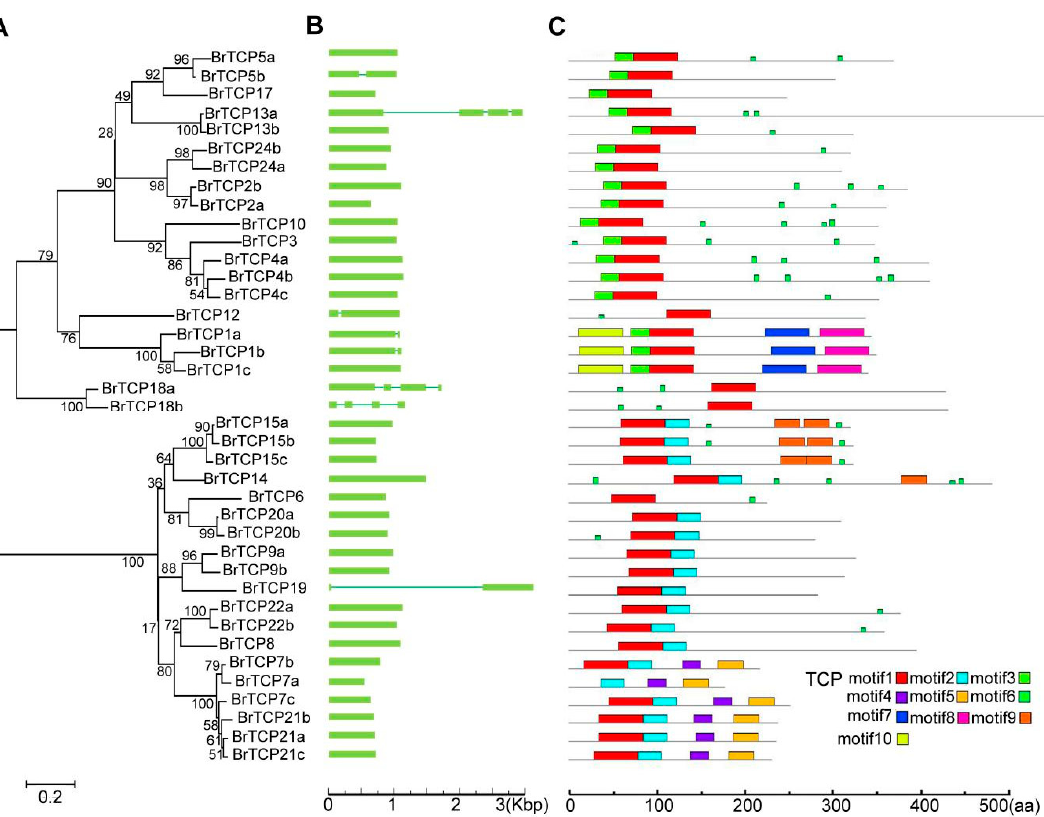
Figure 3. The Phylogenetic tree, gene structure and multiple motifs of TCP family in Chinese cabbage. ( A ) Phylogenetic tree was constructed based on the protein sequence of Chinese cabbage by MAGE6.0; ( B ) The gene structure of Chinese cabbage TCPs . Exon and intron were represented by green boxes and lines; ( C ) The multiple conserved motifs of Chinese cabbage TCP proteins. Motifs were identified by an online tool MEME and labeled with colored boxes. Motifs 1–3 belong to the TCP subfamily.